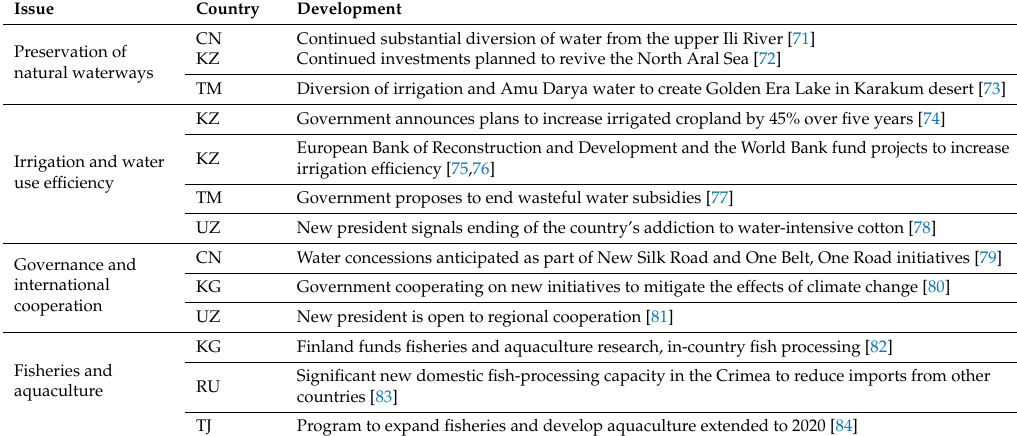
Table 7. Recent policy developments that impact the future of fish and fisheries in Central Asia. Country abbreviations: CN, China; KG, Kyrgyzstan; KZ, Kazakhstan; RU, Russia; TJ, Tajikistan; TM, Turkmenistan; UZ,